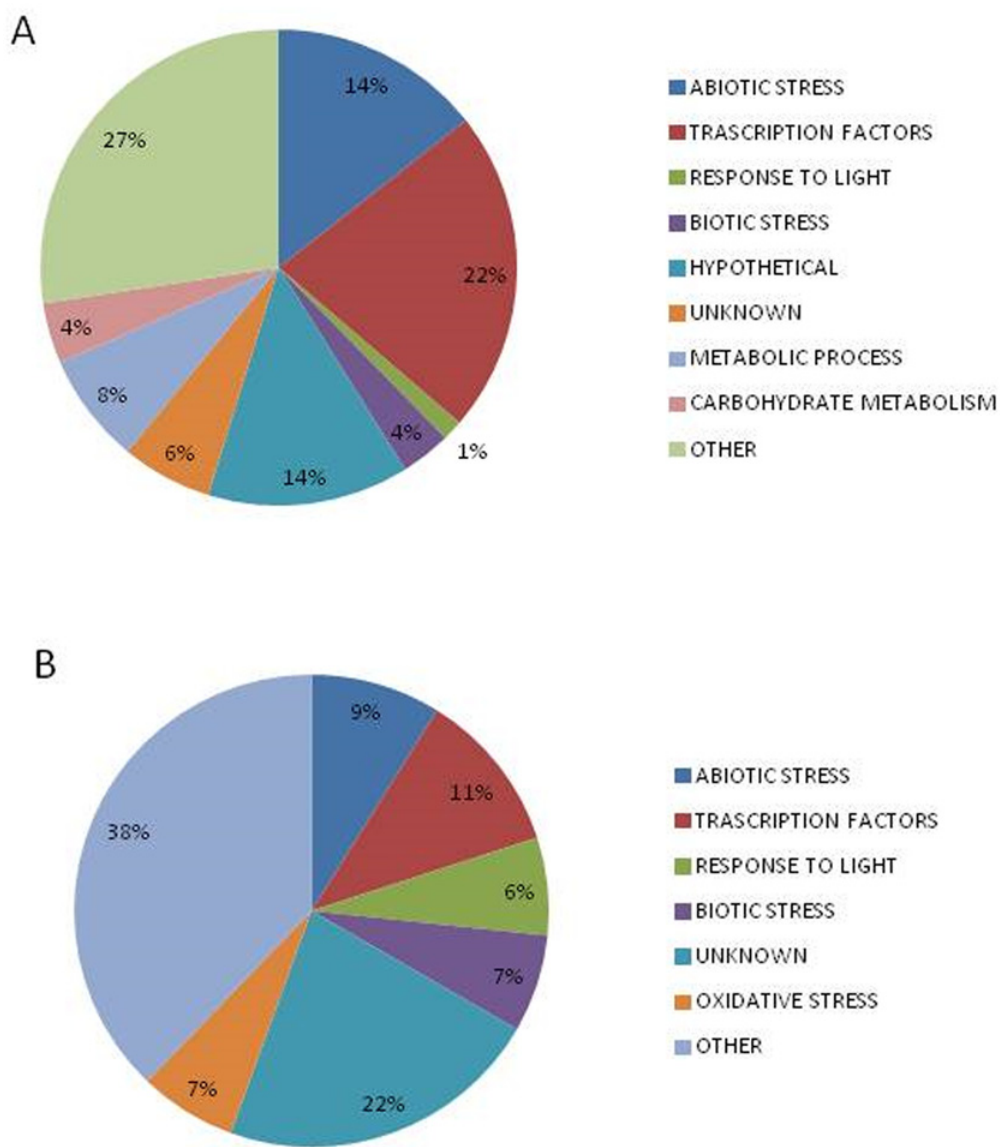
Fig 8. Functional annotation chart of the transcripts up-regulated in Tietar (A) and in DKC6575 (B) in response to drought